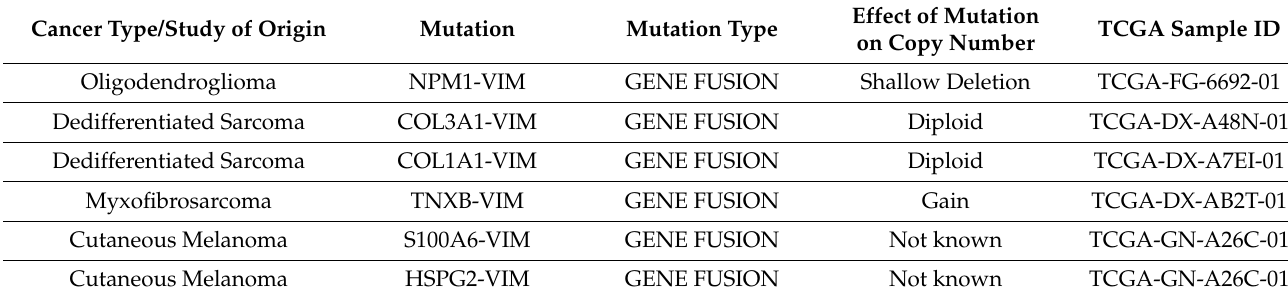
Table 2. Mutations detected in vimentin in different human cancers. Data extracted from The Cancer Genome Atlas database (TCGA)